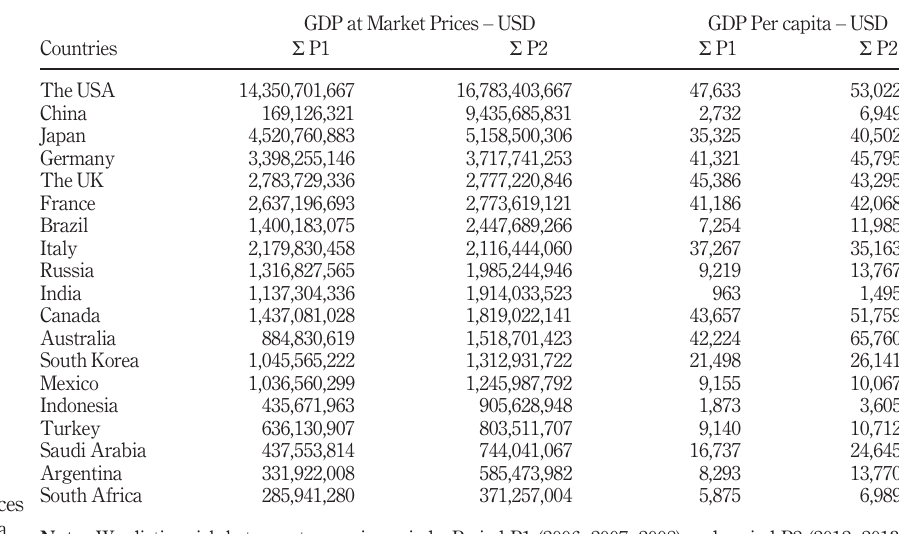
Table III. GDP at market prices and GDP per capita (USD) for the G-20 (19)